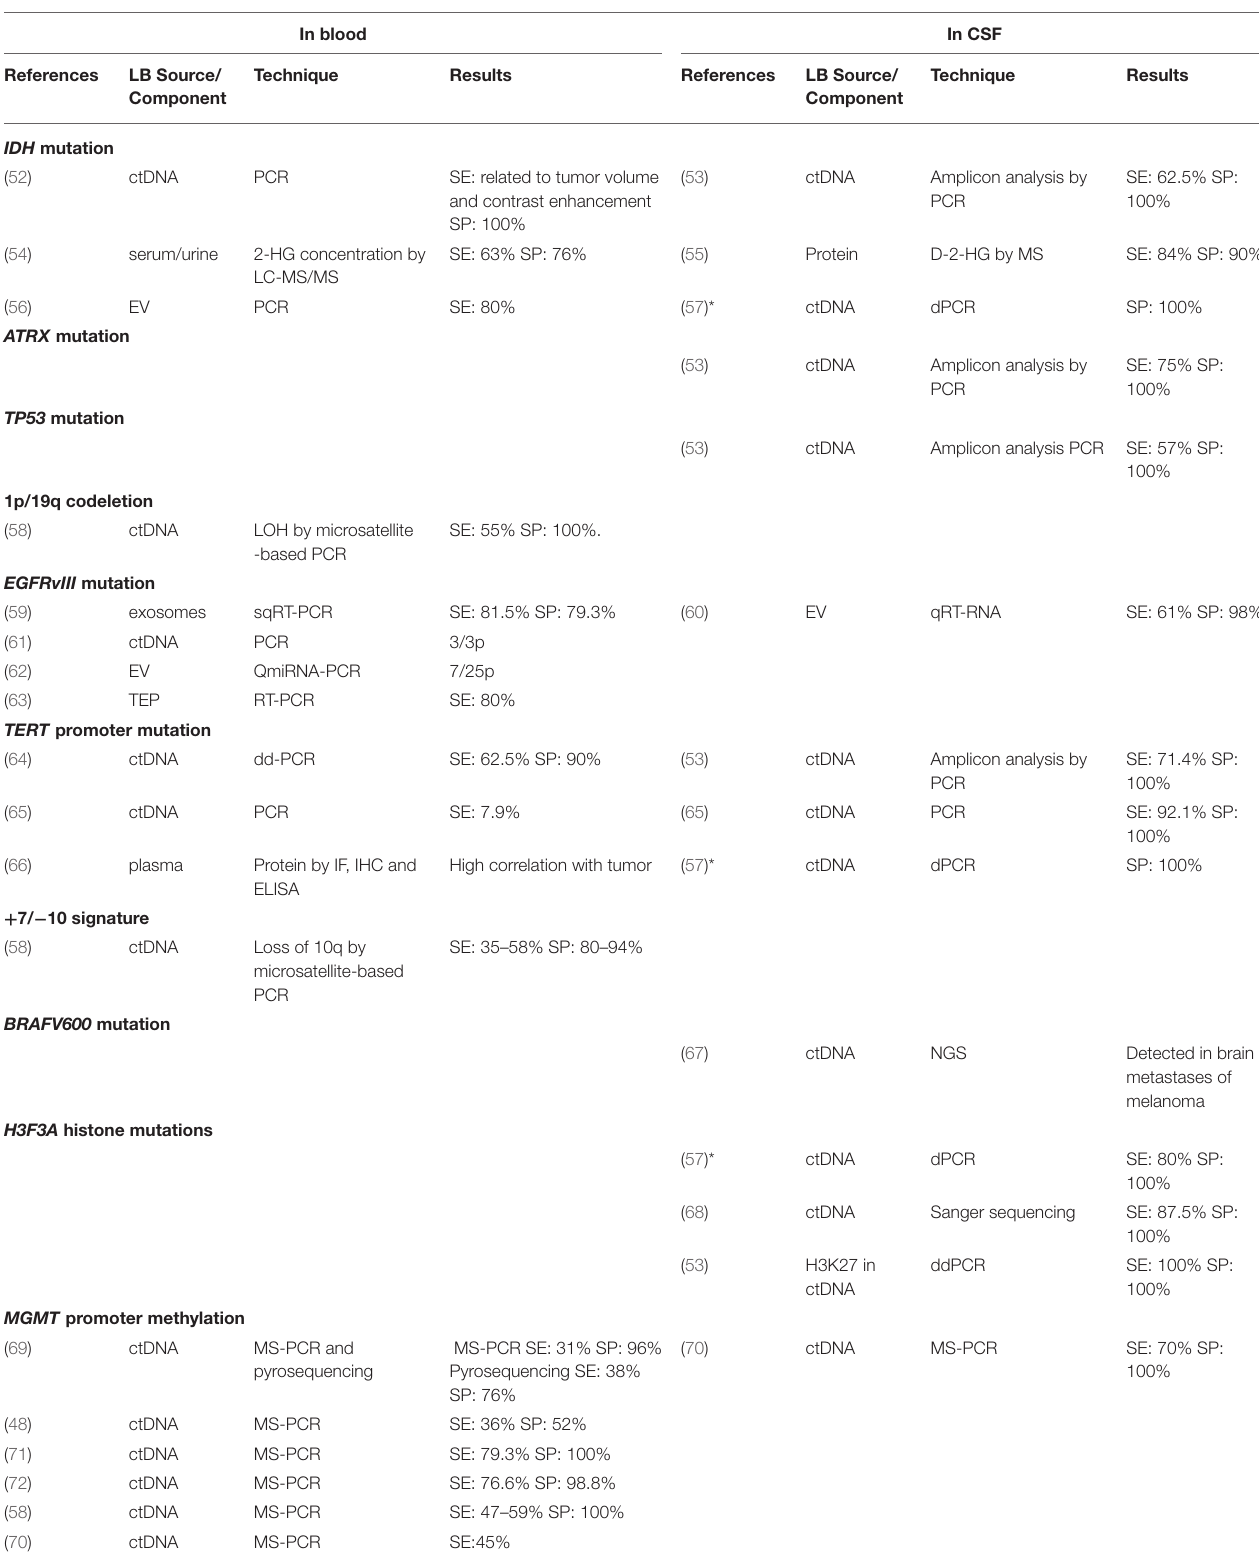
TABLE 2 | Liquid biopsy studies of molecular alterations essential for the diagnosis of gliomas. In blood In